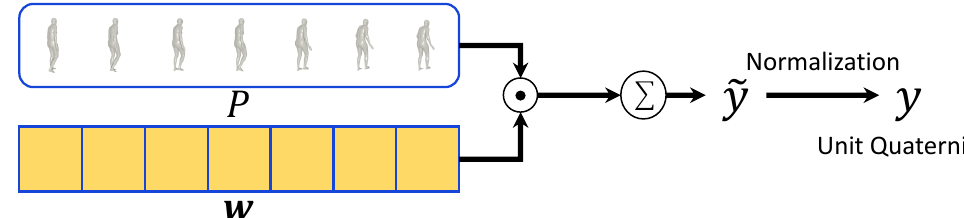
Figure 4. Detailed pipeline of the weighted-averaging module. (cid:12) represents element-wise multipli- cation with broadcasting. Σ represents summation for across time dimension. Input pose vectors P are multiplied with pose affinity weights w which are generated by the weight-regression module. Then weighted pose vectors are added to output a refined pose vector ˜ y . To ensure that the refined pose parameters consist of unit quaternions, we additionally normalize ˜ y to output a valid pose vector y